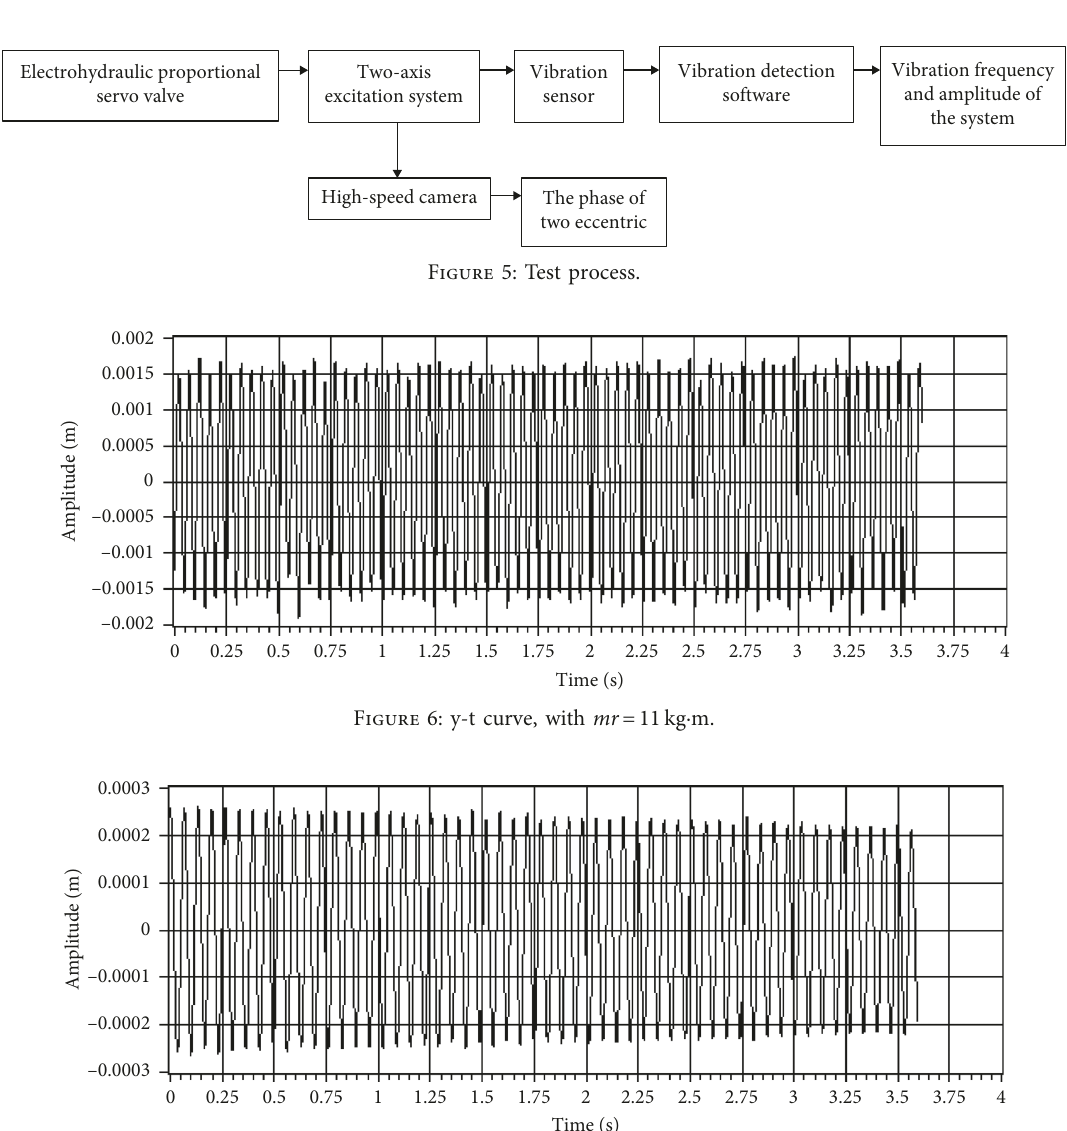
Figure 7: y-t curve, with mr